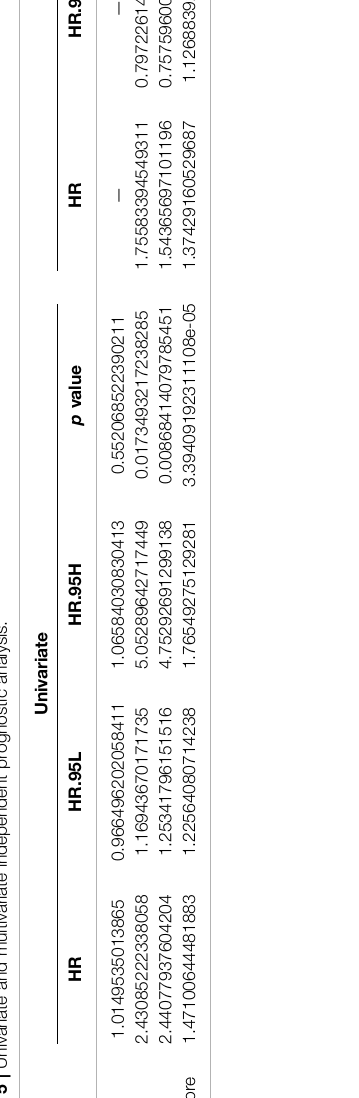
PCa. ( Figure 6 ). Univariate and multivariate